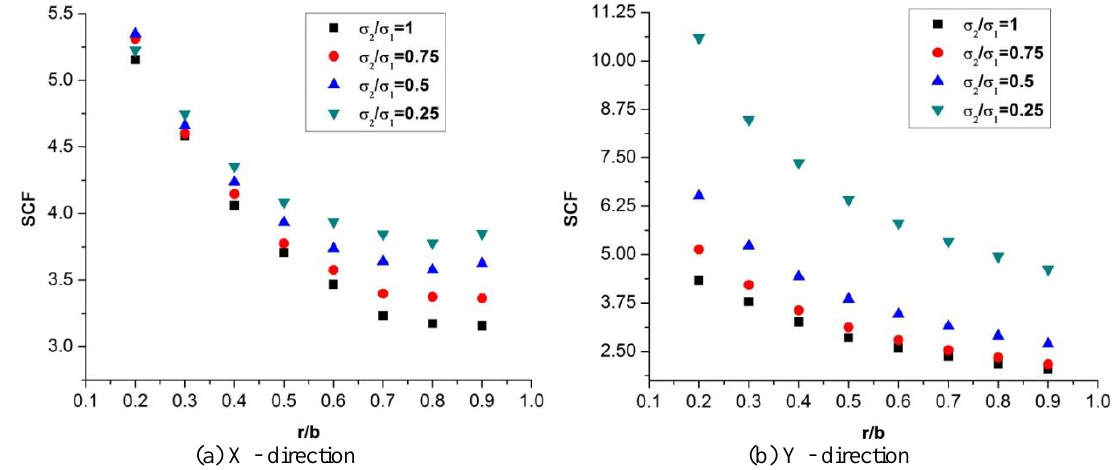
Figure 10. Variation of SCF with loading ratio for b/a =